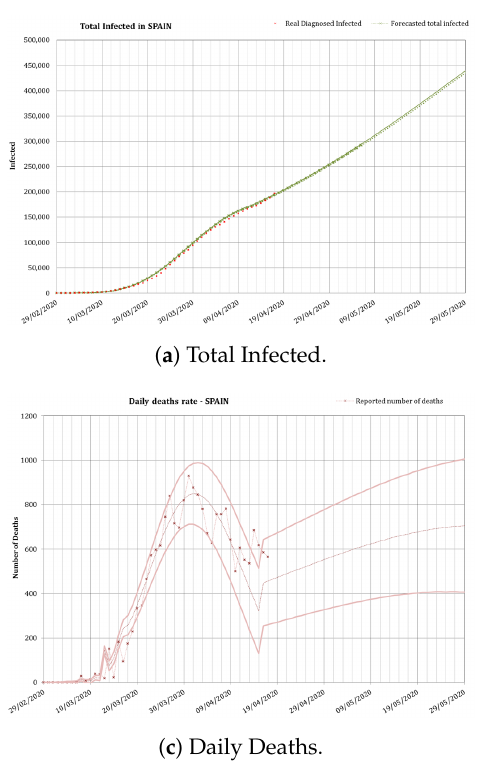
Figure 8. Total number of infected (a) , total deaths (b) and daily deaths (c) in Spain predicted from 29 February/29 May. These modelled results assumed the ease of the lock-down since the 13 April with conservative assumptions for N and r . Red dots—reported data. Green bars—modelled values with